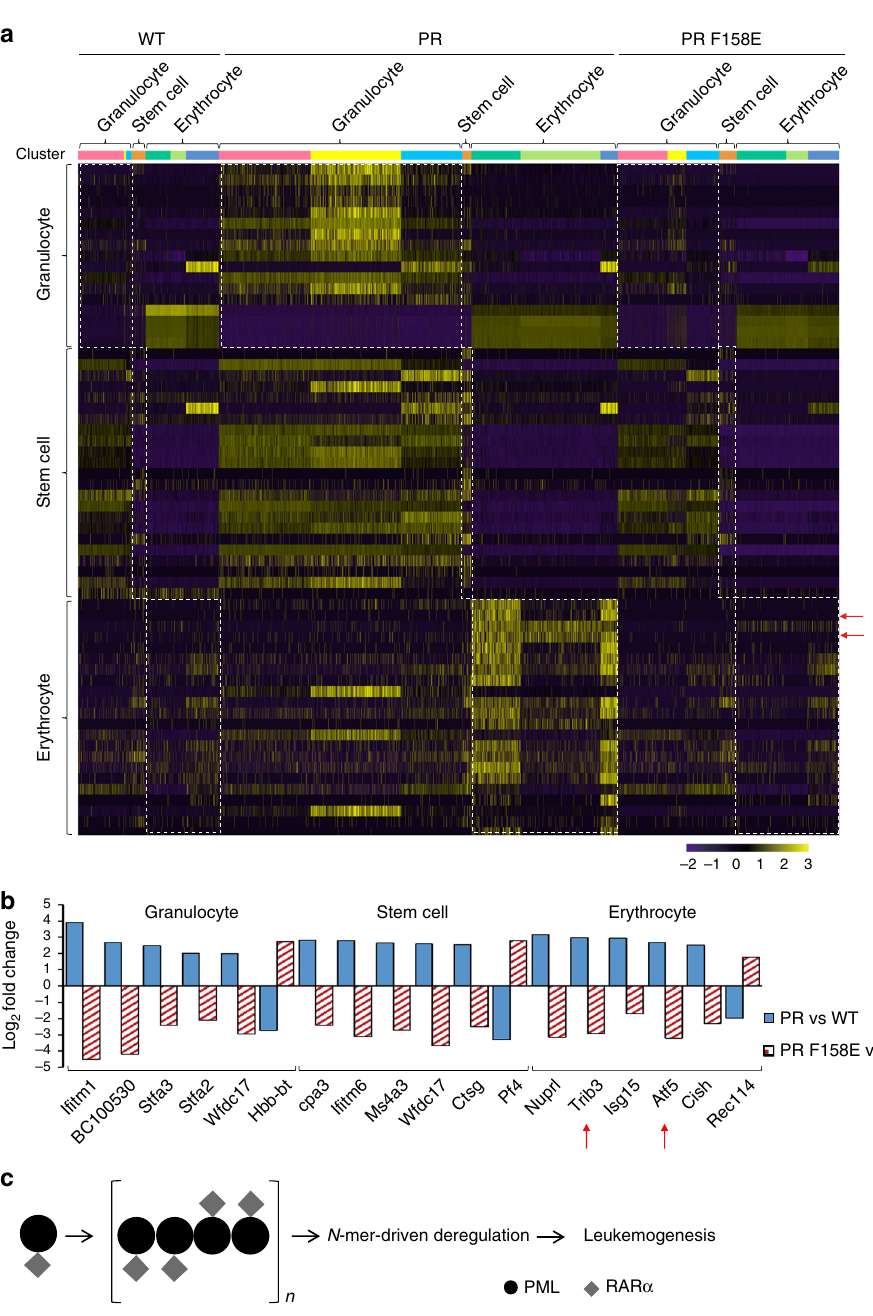
Fig. 9 Abnormal transactivation regulated by B1 oligomerization. a Heat map of PML-RAR α -oligomerization-driven transactivation. The equivalent sets of PML-RAR α target genes in granulocyte, stem cells and erythrocyte cells are boxed, respectively. The transcription expression levels were calculated as normalized UMI value. The genes Trib3 and Atf5 recently reported in APL are highlighted with arrows 32 . b The differential expression analysis of PR and PR F158E datasets reveals a novel set of PML-RAR α oligomerization target genes. The intersection/overlap between the up-regulation (PR vs. WT) and downregulation (PR vs. PR F158E) was used to predict PR-oligomerization-driven transactivation that might underpin APL leukemogenesis. Like a , Trib3 and Atf5 are highlighted with arrows. c A revised model of polymer-driven